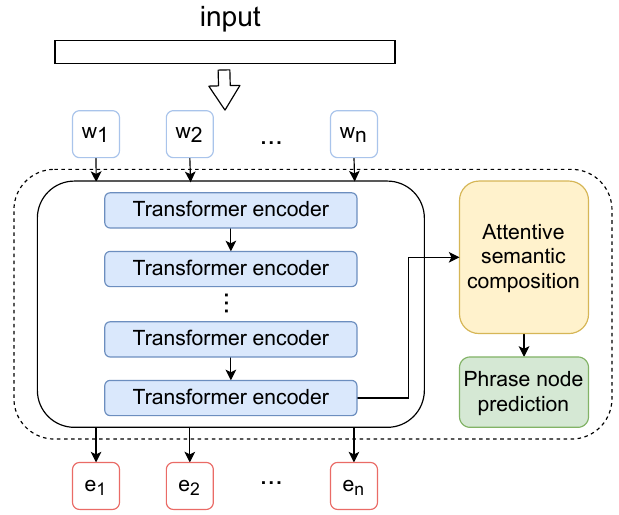
Figure 4. Module I: